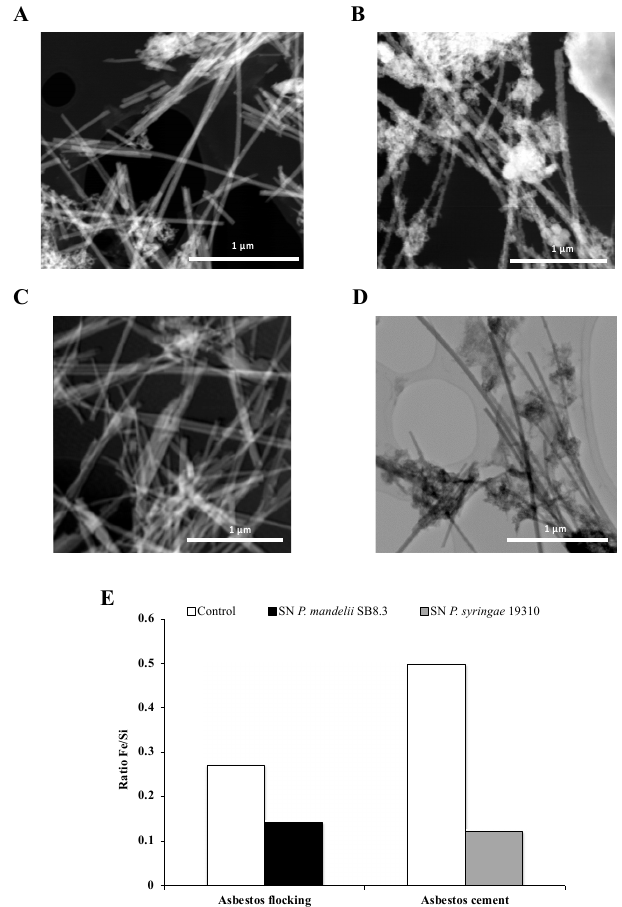
Figure 8. STEM images of chrysotile fibers from asbestos flocking and asbestos cement after respectively 42 and 20 days of total incubation in the presence of succinate ( A ) or casamino acids ( B ) medium as a control, Pseudomonas mandelii ( C ) or Pseudomonas syringae ( D ) pyoverdine-containing supernatants (SN). Atomic ratios of Fe/Si of total area (E). Adapted from David et al. [72,80].